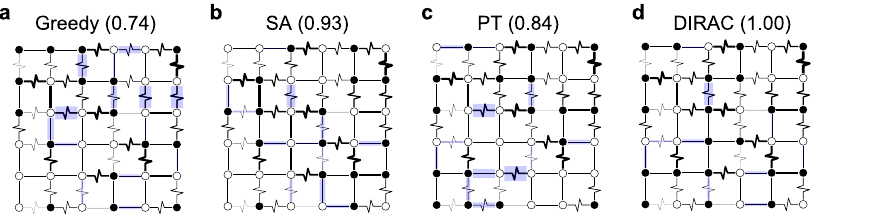
hypercubic lattice with N = L D sites (see Fig. 1 for 2D instances) and σ